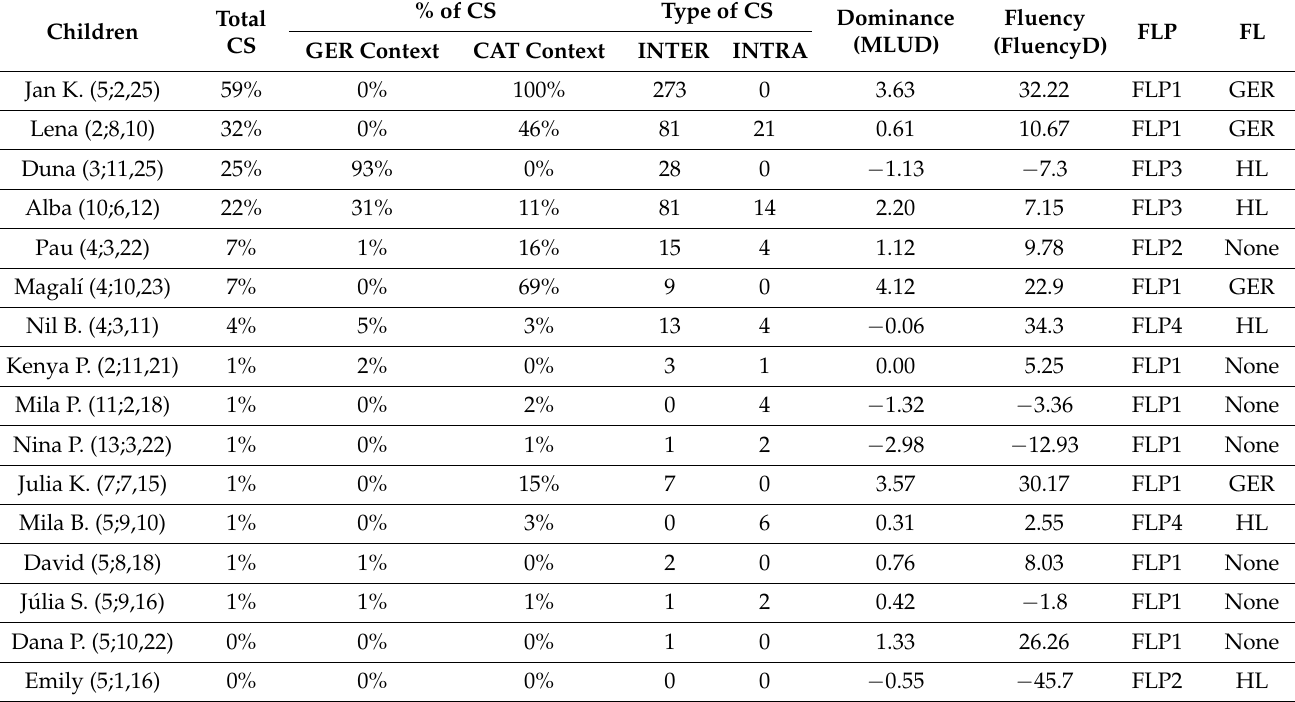
Table 7. Children’s CS depending on internal and external